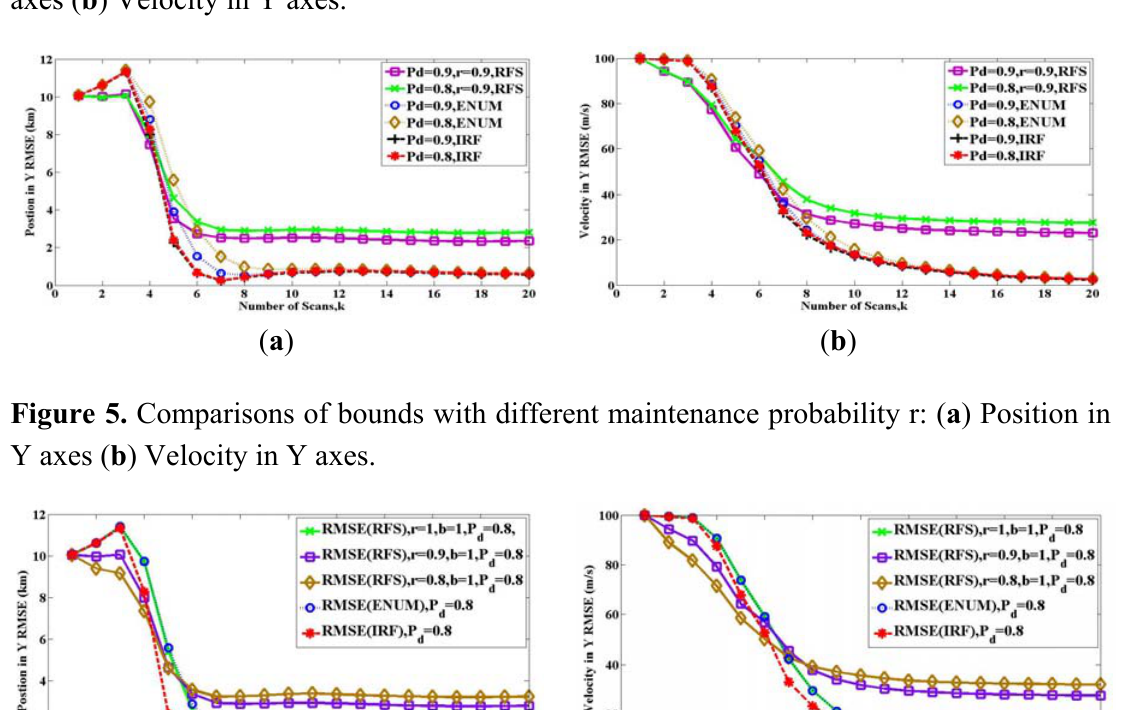
: ( a ) Position in Y D